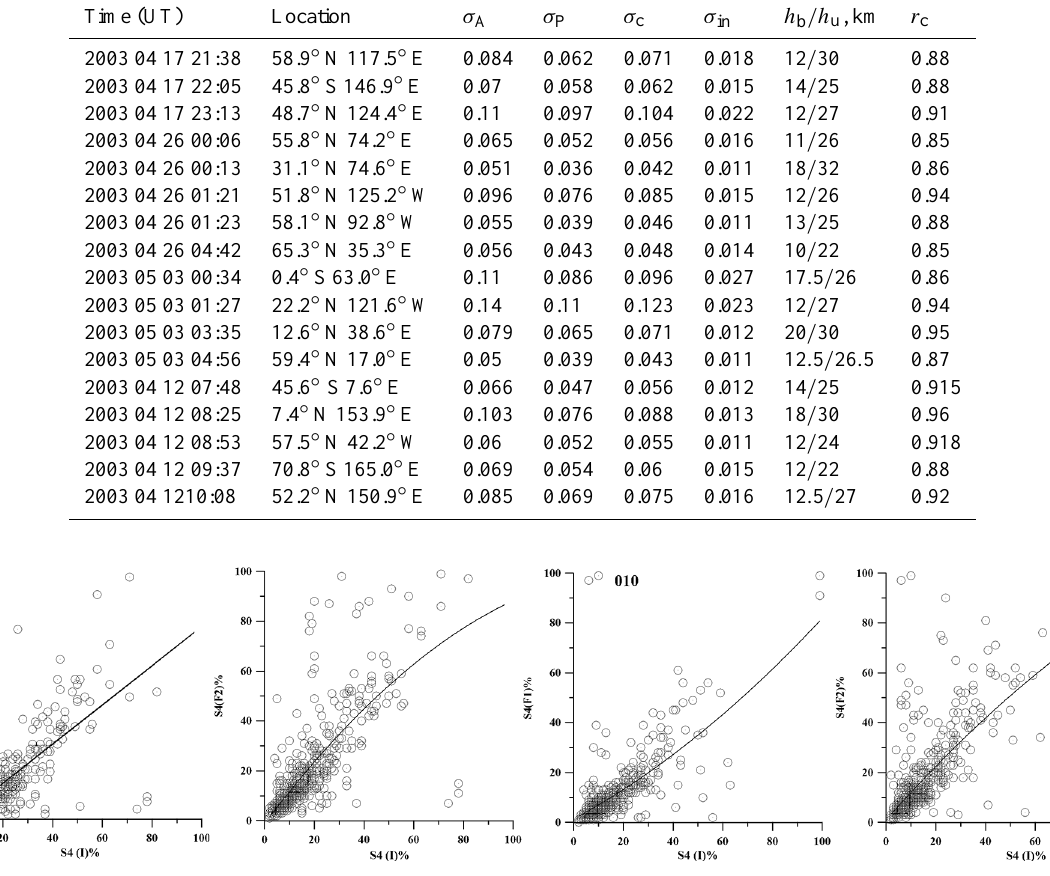
Table 1. Parameters of coherent and incoherent components.